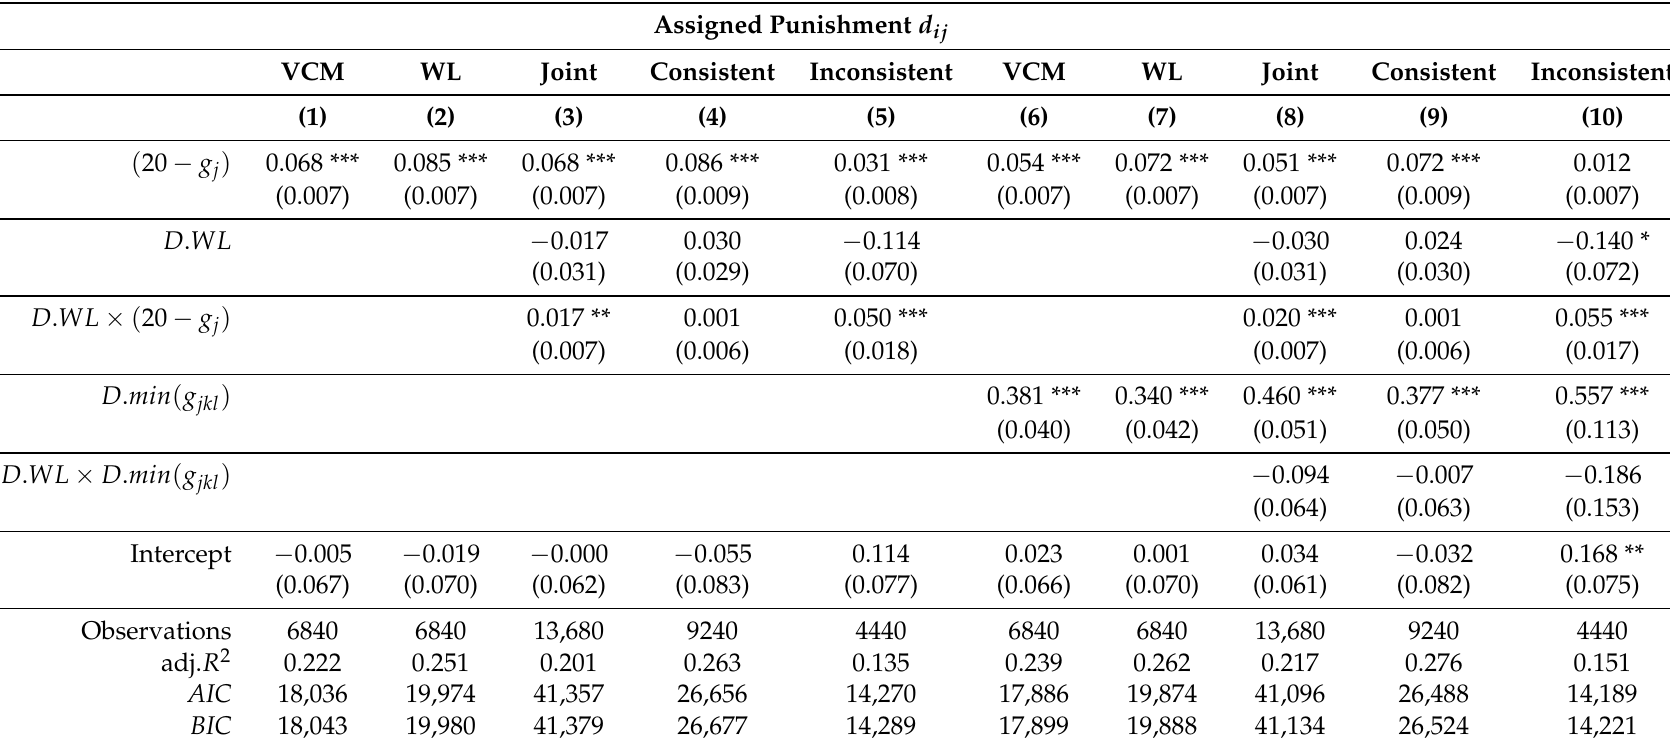
Table A1. Punishment demand